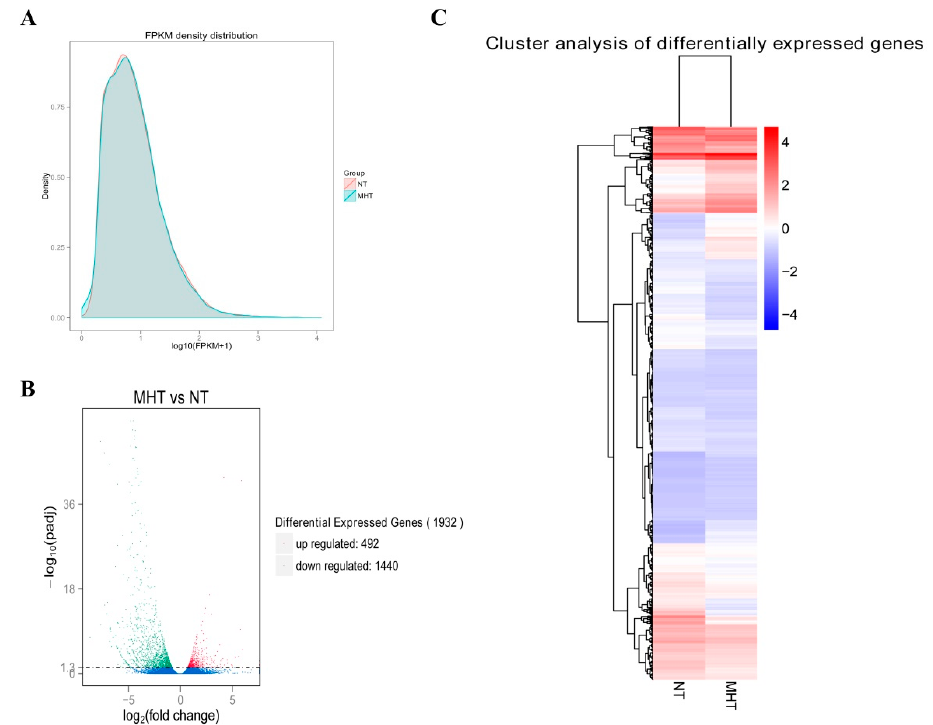
Figure 3. Expression analysis of differentially expressed genes (DEGs) between NT and MHT exposed tobacco leaves. ( A ) Fragments per kilobase of exon per million fragments mapped (FPKM) density distribution between NT and MHT tobacco leaf transcriptomes. ( B ) Volcano plot of DEGs between NT and MHT tobacco exposed leaves. The mean expression value of -log 10 (padj) is plotted on the ordinate, and the log 2 (fold change) value is plotted on the abscissa. Each dot represents an individual gene. Red dots represent significantly upregulated DEGs, and green dots represent significantly downregulated DEGs. Blue dots represent genes whose expression was not significantly different between the two treatment groups. ( C ) Hierarchical clustering analysis of DEGs between